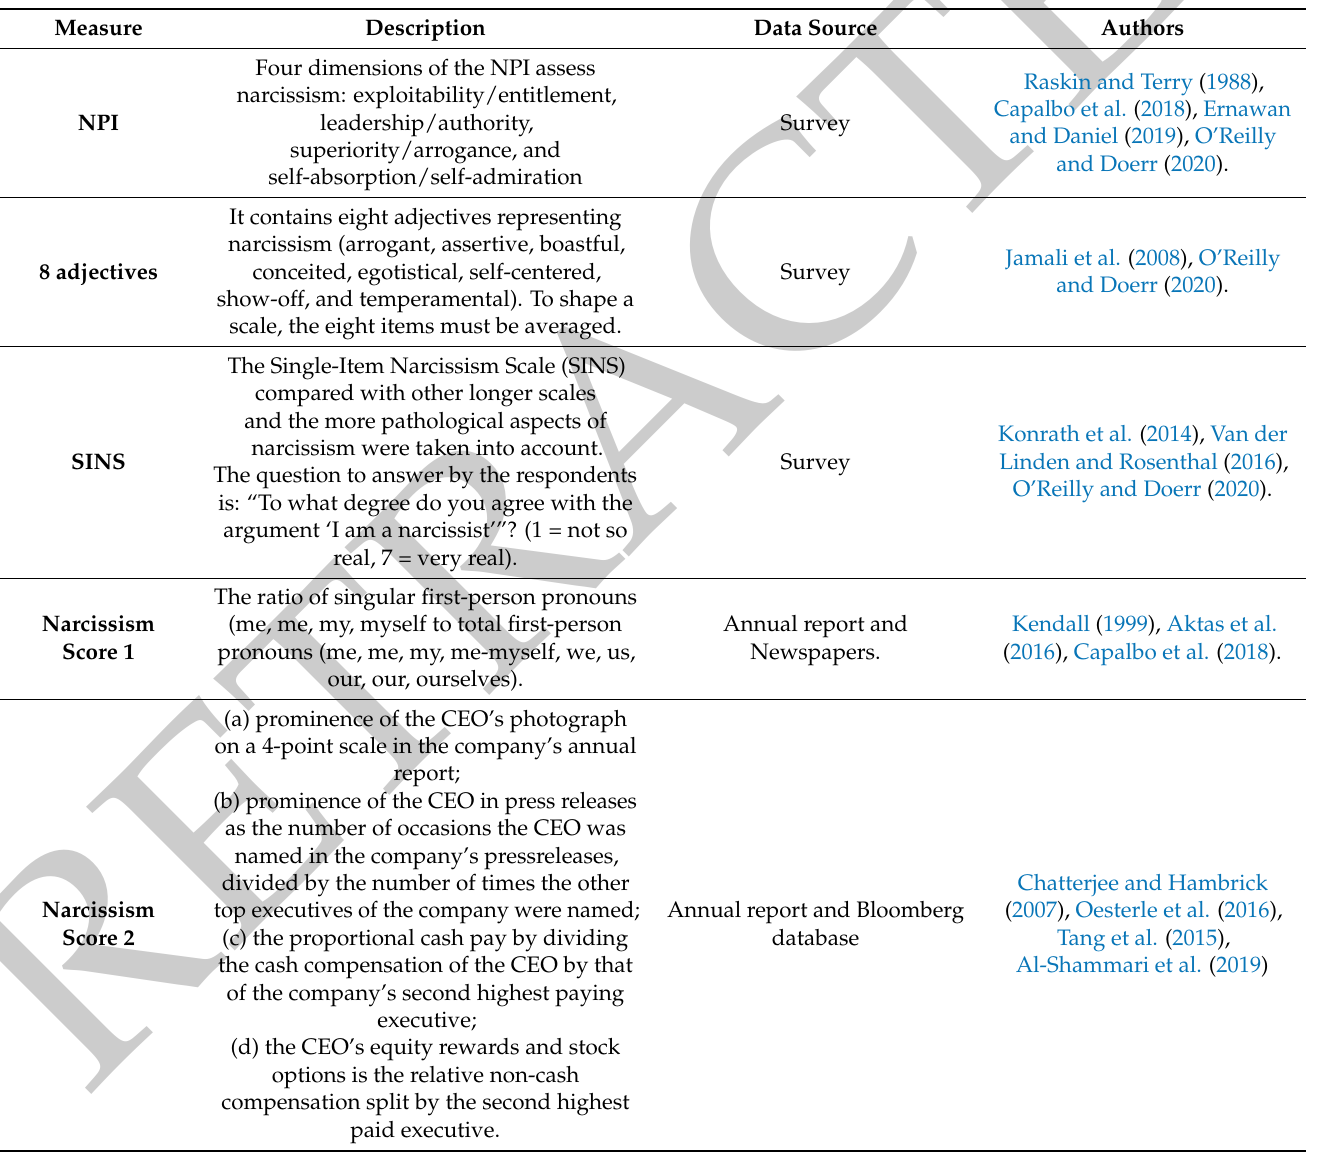
Table 2. A review of the different CEO narcissism